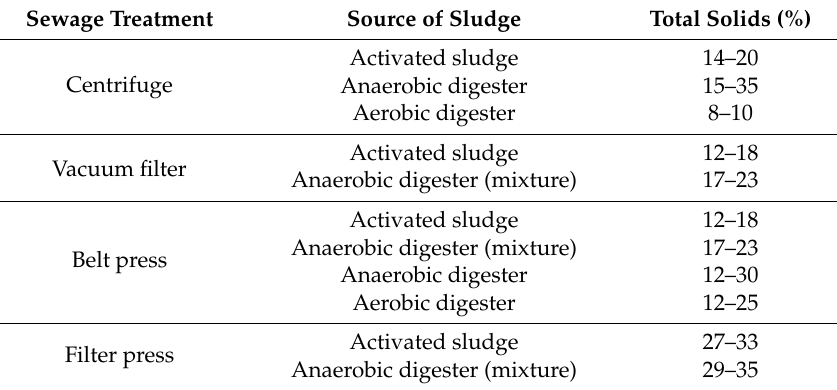
Table 2. Typical total solid content after sludge dewatering treatment